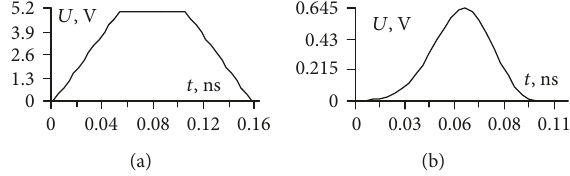
Figure 3: EMF waveforms for the overall duration of 150 ps (a) and 108ps